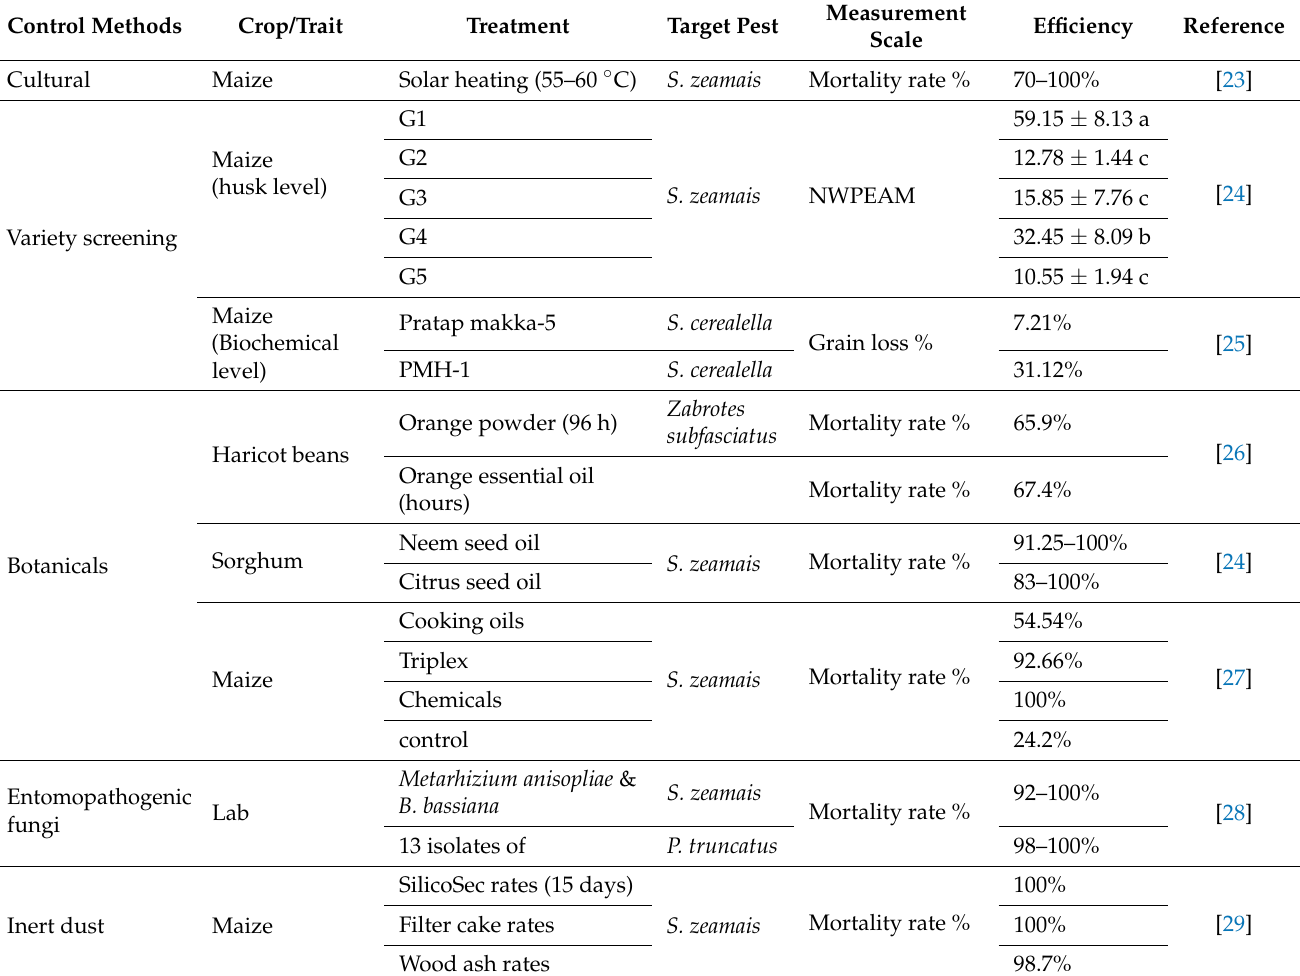
Table 2. Comparison analysis on effectiveness of storage pest control methods in